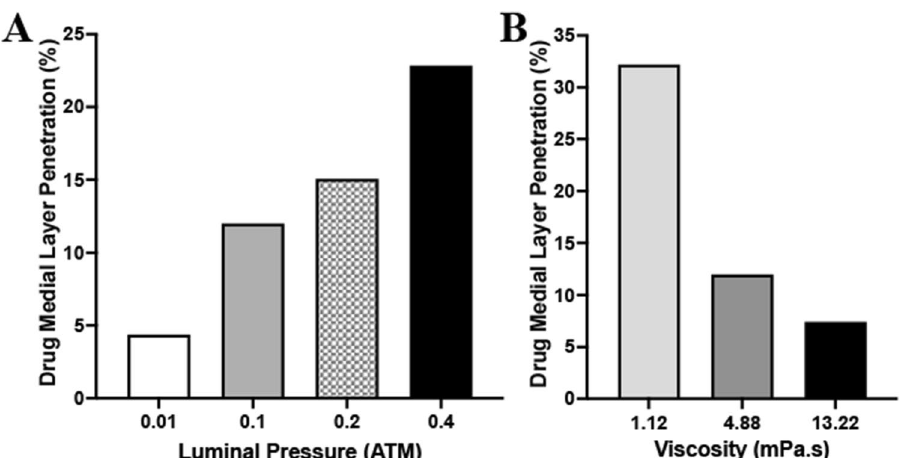
Figure 3. Mathematical results of varying pressures and viscosities. ( A ) Medial penetration depth of varying luminal pressures ranging from 0.01 to 0.4 atm. ( B ) Medial penetration depth of varying liquid viscosities ranging from 1.12 to 13.22 mPa